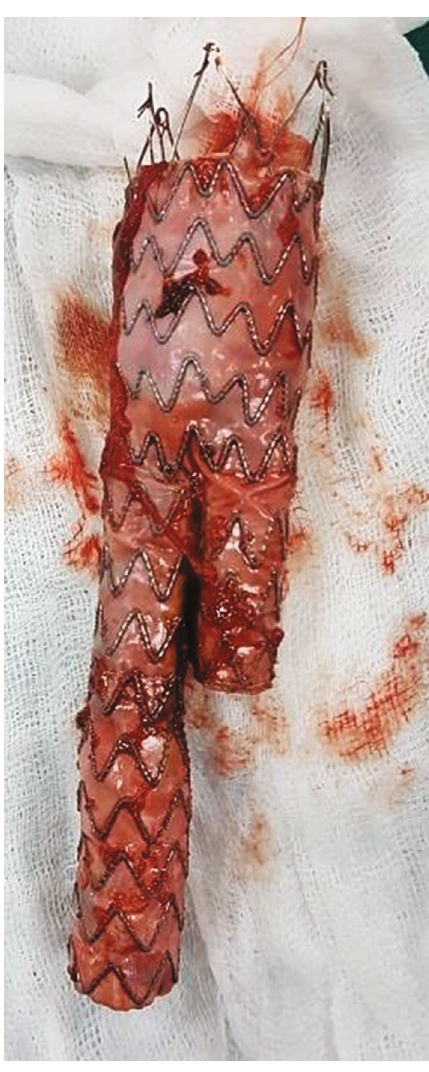
Figure 2: Explanted stent graft.